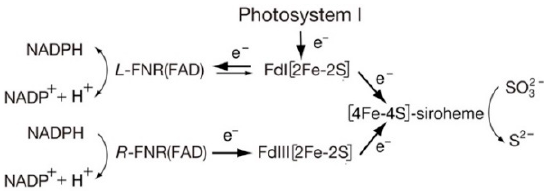
Figure 11. Electron transfer cascades for plant sulfite reductase. Figure was adapted with permission from Refs. [132,133] with some modifications. Copyright year 2005, Hase et al. (2005). Both the electron transfer systems catalyze the six-electron reduction of sulfite (SO 32 −